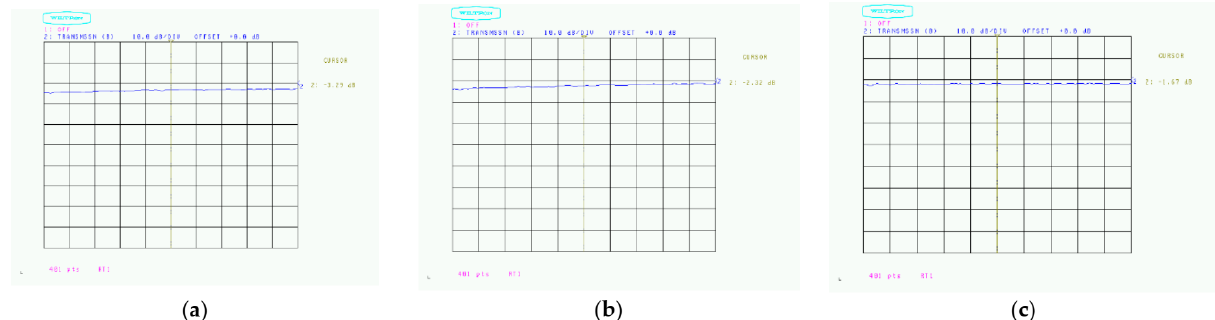
Figure 13. Radio wave absorption of carbon black paint: ( a ) Coating thickness 16 µ m (3.29 dB); ( b ) Coating thickness 35 µ m (2.32 dB); ( c ) Coating thickness 76 µ m (1.62 dB).